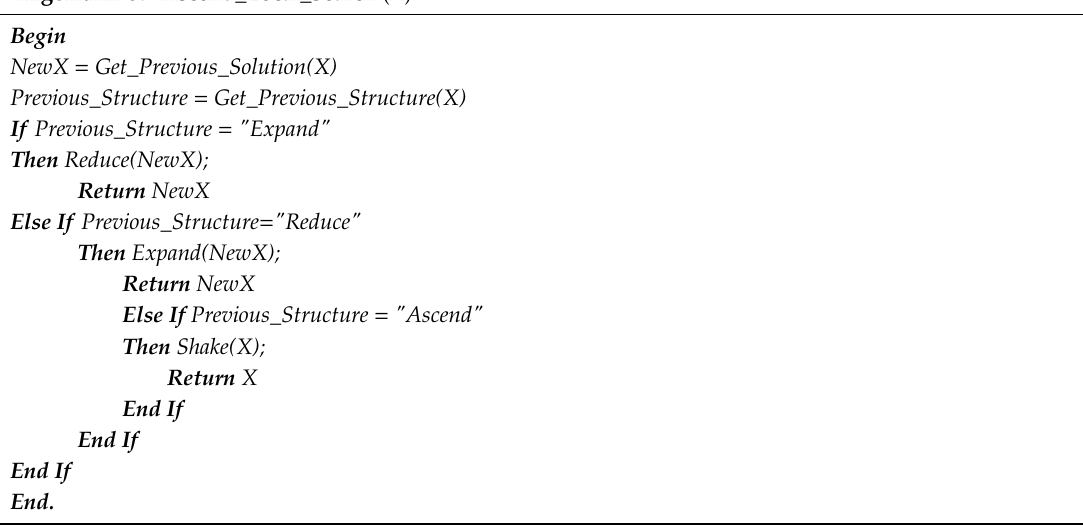
Algorithm 5. Ascend_Local_Search (X).